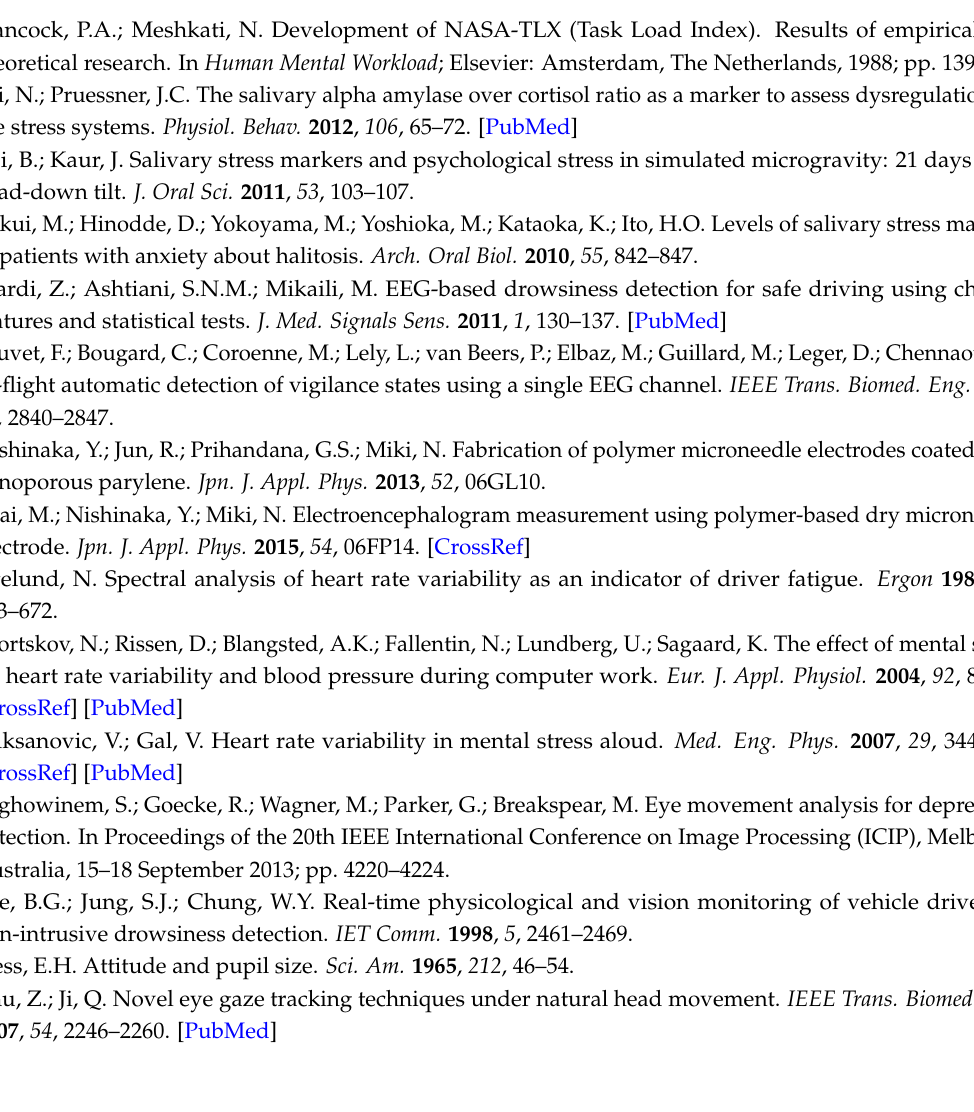
Figure S1: Relations between the viewing angle and the output voltage ( a ) V H and ( b ) V V for one subject. Figure S2: First derivative of the output voltage of the sensor when the subjects blinked naturally. Table S1: Acquired information for subject